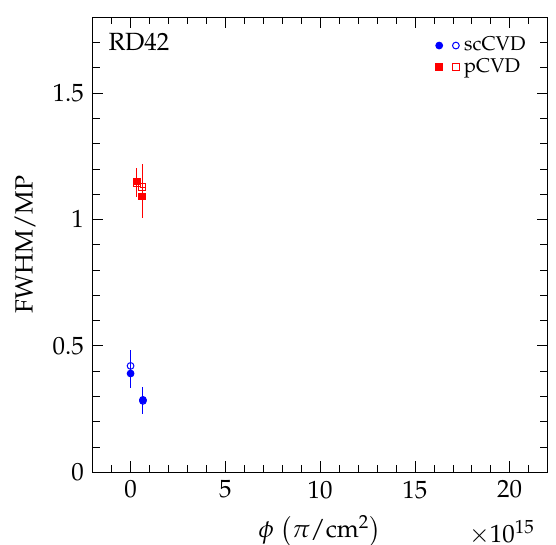
Figure 14. The FWHM/MP as a function of fluence in the pion irradiation measured in a + 120GeV/ c hadron beam at CERN. The two values shown at each fluence are the values for positive (solid markers) and negative bias (open markers) at E = 2V/µm.